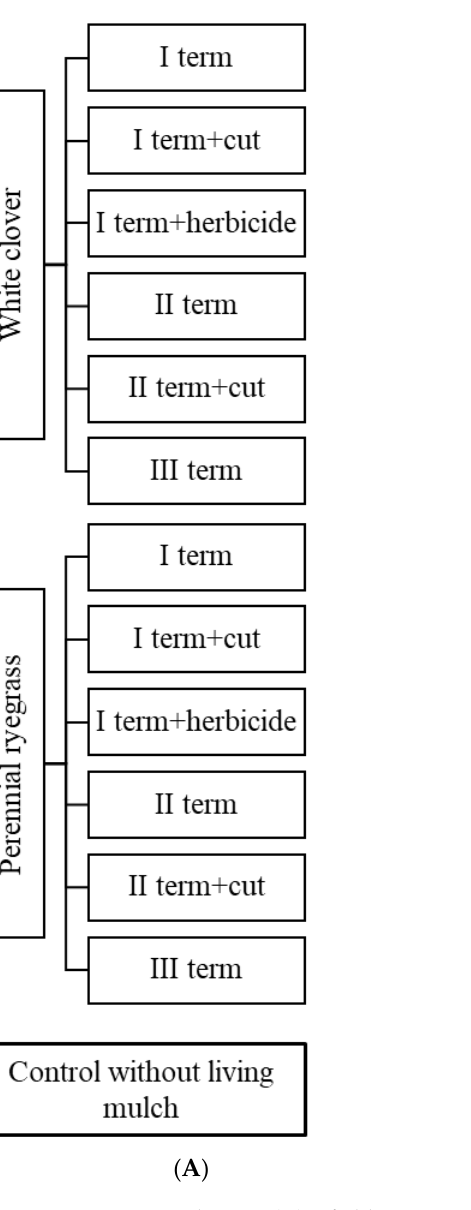
Figure 1. Experiment design . ( A ) — field experiment layout for living mulches management and eggplant yielding. ( B ) — field experiment layout for soil physical parameters.